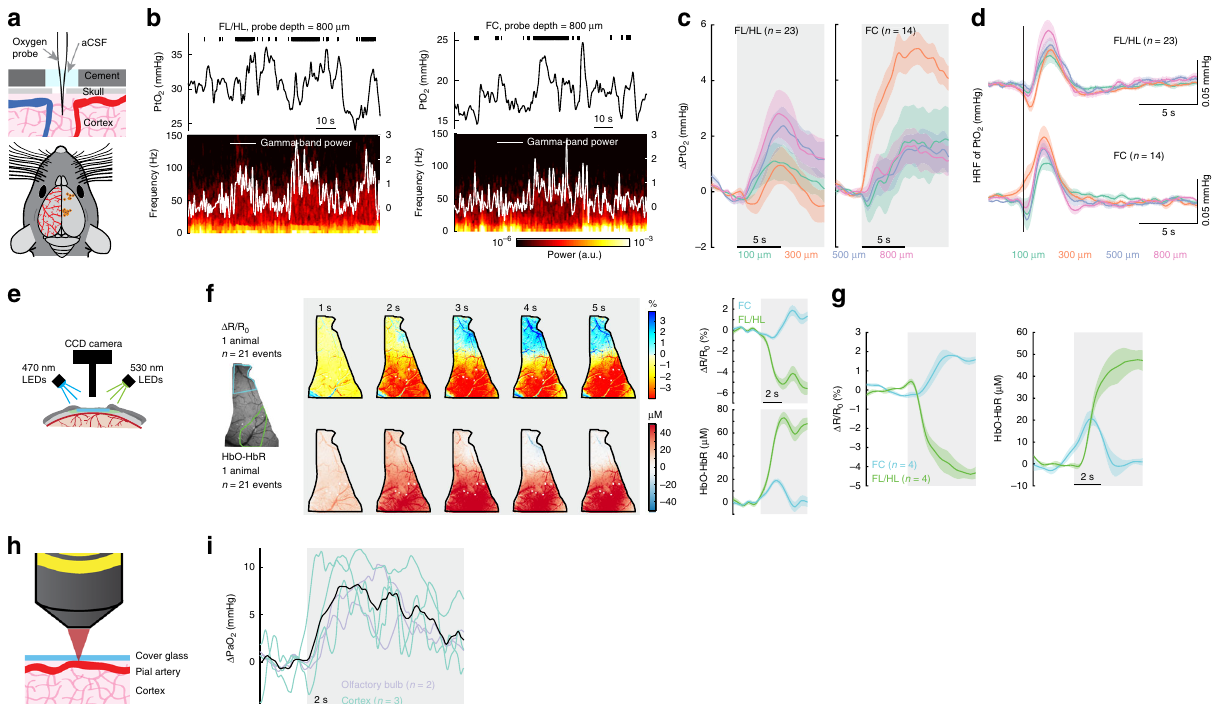
Fig. 2 Cortex-wide increases in oxygenation during locomotion. a Top, experimental setup. Bottom, measurement sites. b Example traces showing PtO 2 responses to locomotion at sites 800 µ m below brain surface in FL/HL (left) and FC (right). Top, black ticks denote binarized locomotion events; Middle, PtO 2 responses to locomotion; Bottom, example of data showing spectrogram of LFP (white trace showing the gamma-band LFP power). c Locomotion- evoked cortical tissue oxygenation increases ( Δ PtO 2 ) at all measured depths in both FL/HL (left, n = 23 mice) and FC (right, n = 14 mice). Gray shaded area indicates locomotion. d HRF of tissue oxygenation at different depths in both FL/HL (top, n = 23 mice) and FC (bottom, n = 14 mice). Vertical black line showing the start of a brief impulse of locomotion. e Schematic showing the optical imaging spectroscopy setup. f Left, example data showing spatial distribution of locomotion-evoked response of Δ R / R 0 and HbO-HbR in an example mouse. Right, locomotion-triggered average of Δ R / R 0 and HbO-HbR for the same mouse in FC (blue) and FL/HL (green). g Group average of locomotion-evoked response of Δ R/R 0 and HbO-HbR in FC ( n = 4 mice) and FL/HL ( n = 4 mice). h Schematic showing the measurement of PaO 2 using 2PLM. i Locomotion induced PaO 2 increases in fi ve arteries (three in the cortex (green) and two in the olfactory bulb (purple)) from a total of four mice. Mean response of all arteries is shown as a black line. Solid lines and shaded area in ( c ), ( d ), ( f ) and ( g ) denote mean ± SEM,